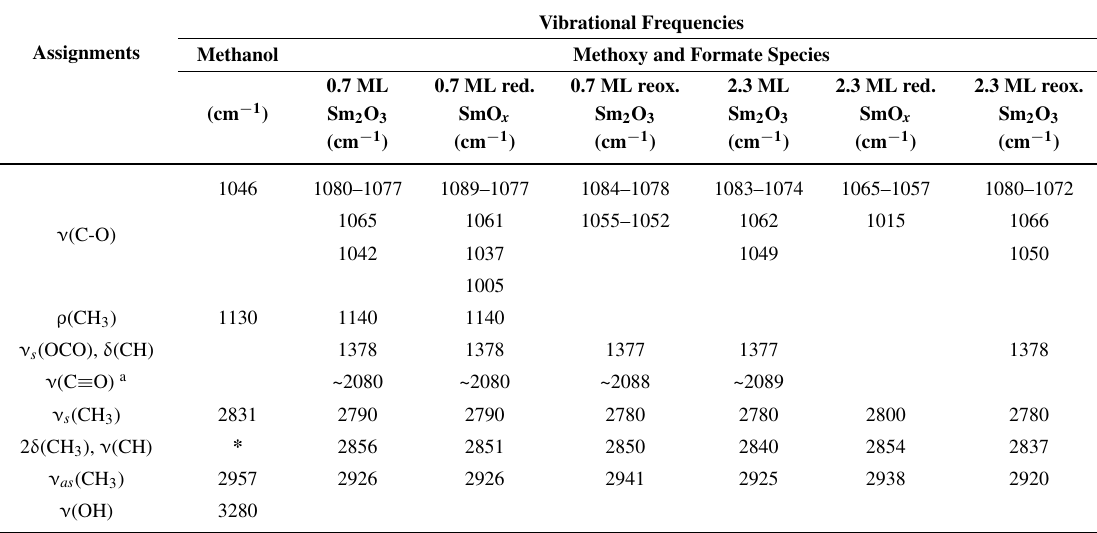
/Pt(111) samples. The corresponding IRRAS x film are shown in Figure x